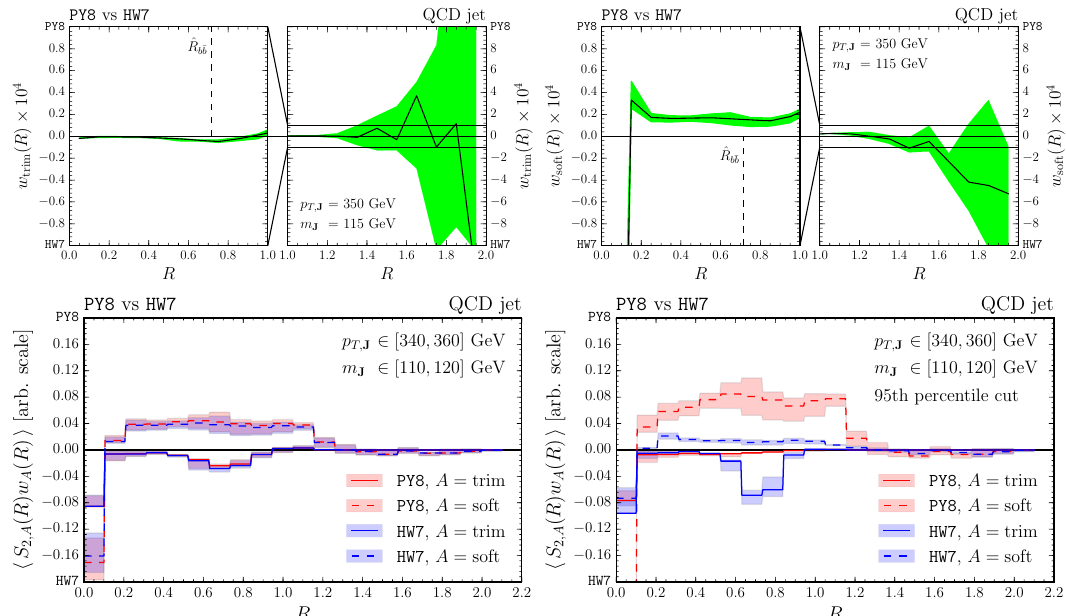
Figure 19 . Top (cid:12)gures are the weights w trim (left) and w soft (right) at p T; J = 350 GeV and m J = 115 GeV for classifying QCD jet of PY8 and HW7 events. Bottom (cid:12)gures are In the right bottom (cid:12)gure, we additionally demand that ^ y 1 of the PY8 generated jets and ^ y 2 of the HW7 generated jets are larger than their 95th percentile respectively. We show their statistical uncertainty from the training samples as colored